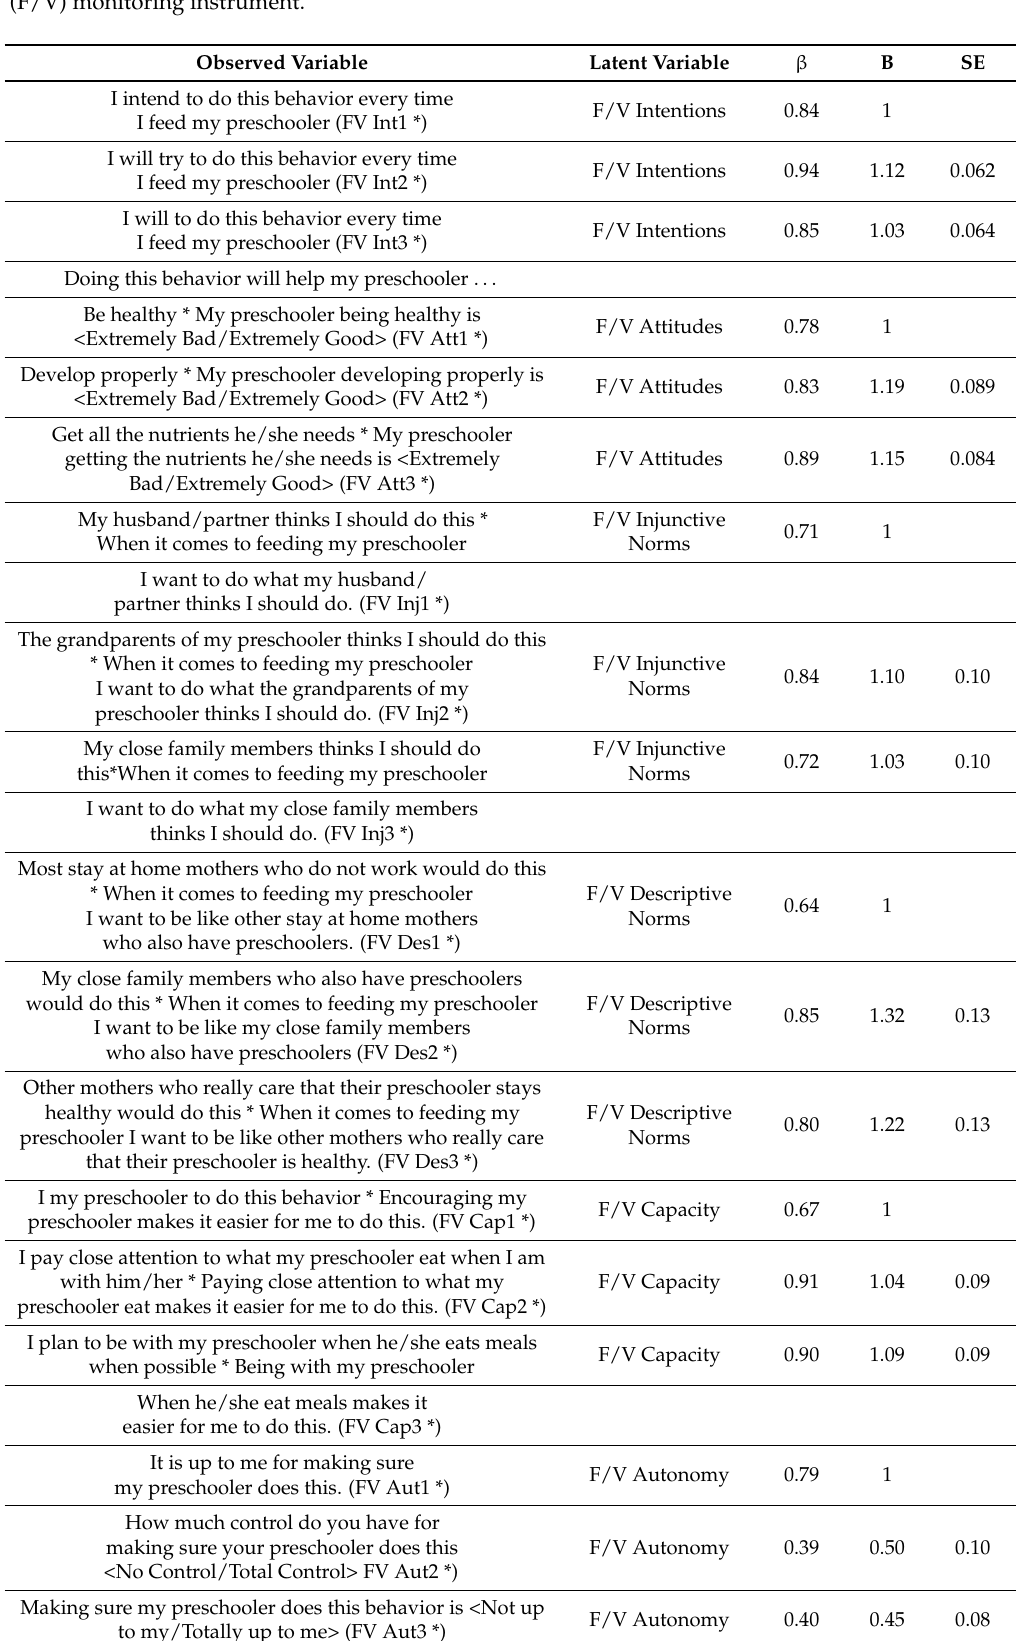
Table 2. Standardized ( β ) and unstandardized ( B ) coefficients for CFA analysis for fruit and vegetable (F/V) monitoring